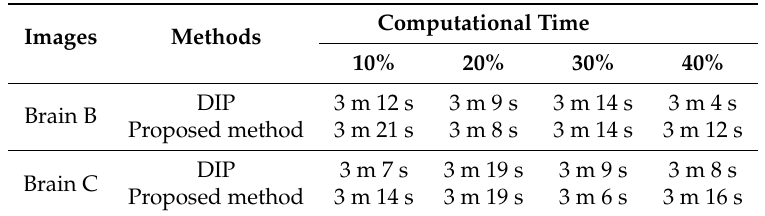
Table 3. The computational time at different sampling rates under the Cartesian mask for DIP and the proposed